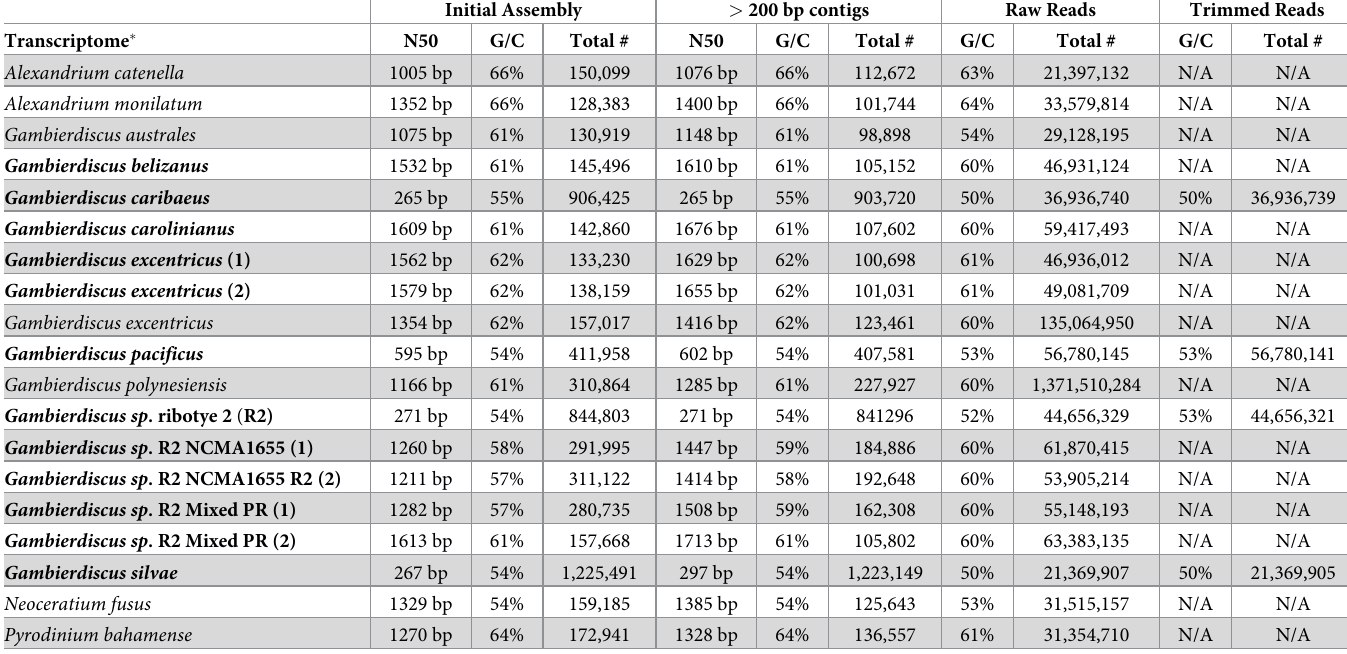
Table 1. Transcriptome